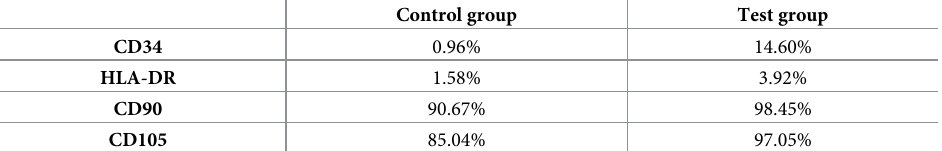
Table 2. The percentages of cell surface markers CD34, HLA-DR, CD90, and CD105 on the cells from control and test